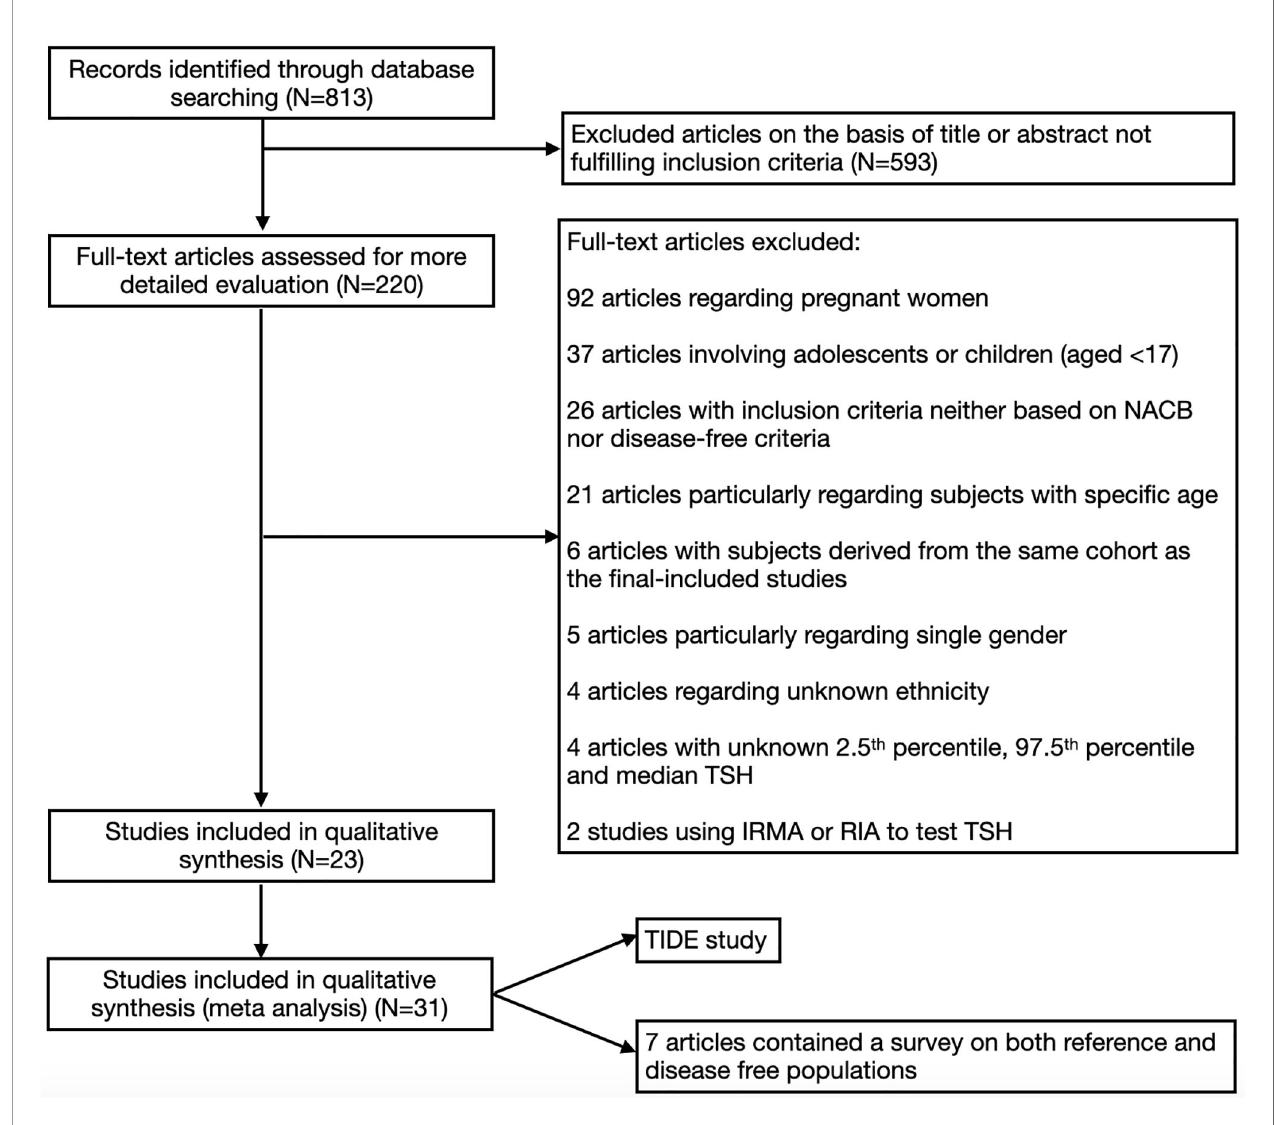
FIGURE 1 | Flow diagram for the literature